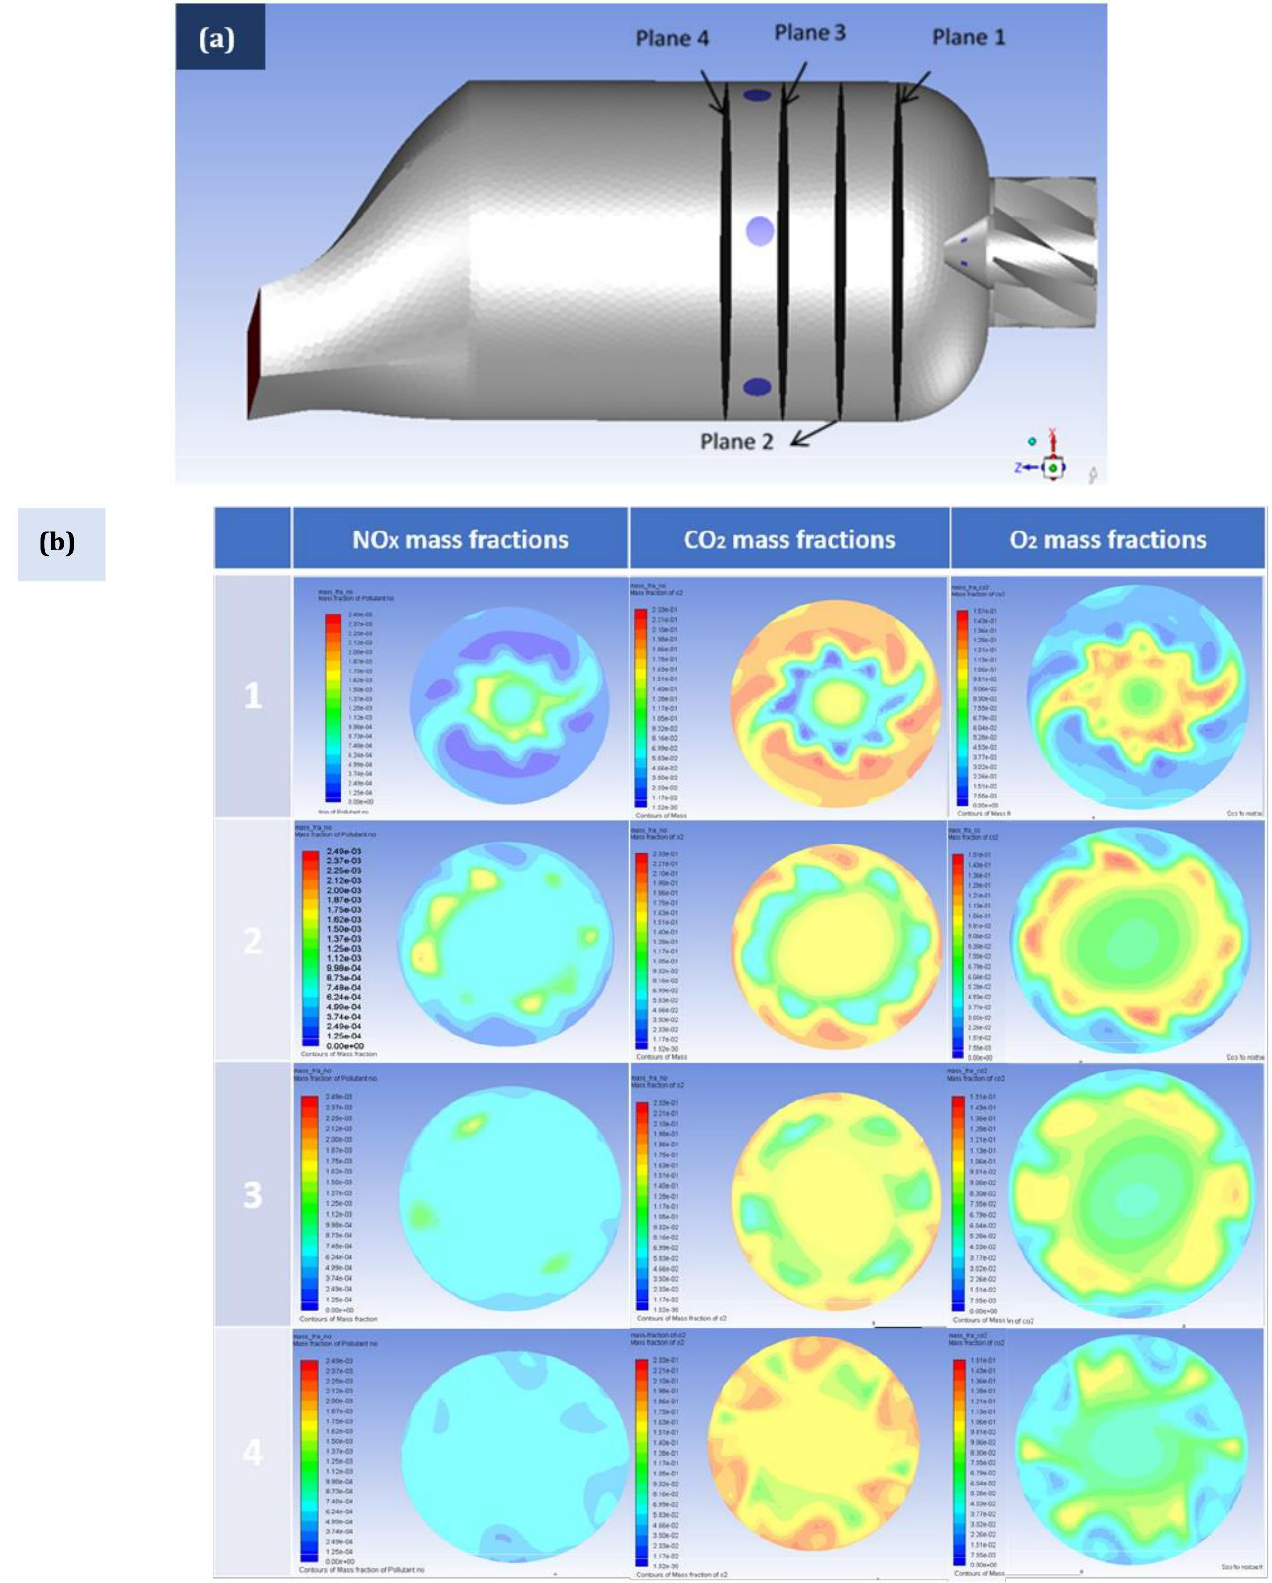
Figure 7. Species formation and distribution across the can combustor at four planes, showing ( a ) the four planes along the combustor and ( b ) the profile contours for the four planes.